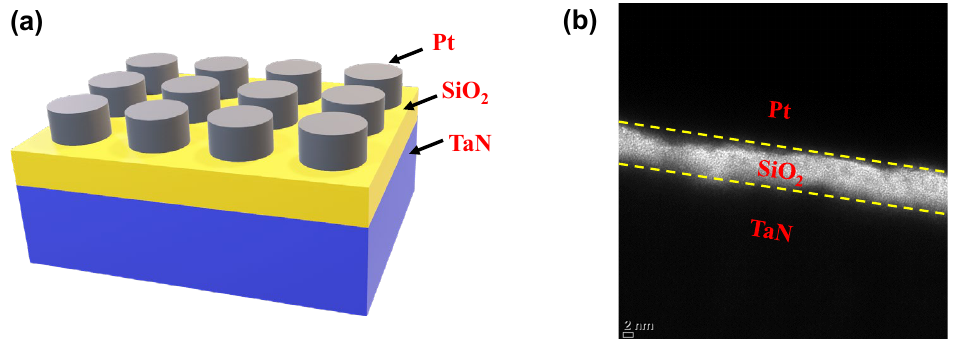
Figure 1. A schematic diagram ( a ) and cross-sectional TEM image ( b ) of the Pt/SiO X /TaN RRAM device.